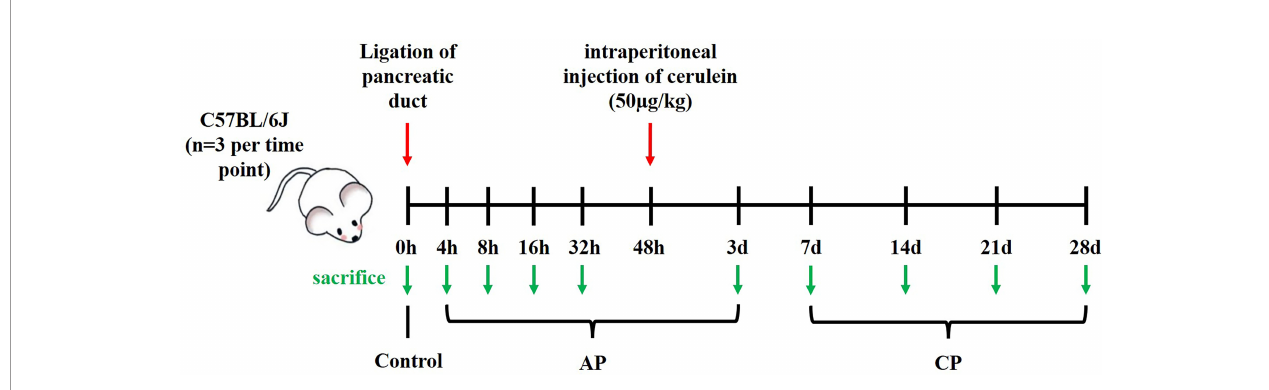
FIGURE 1 | Schematic diagram for constructing a mouse model of pancreatitis induced by partial ligation of the pancreatic